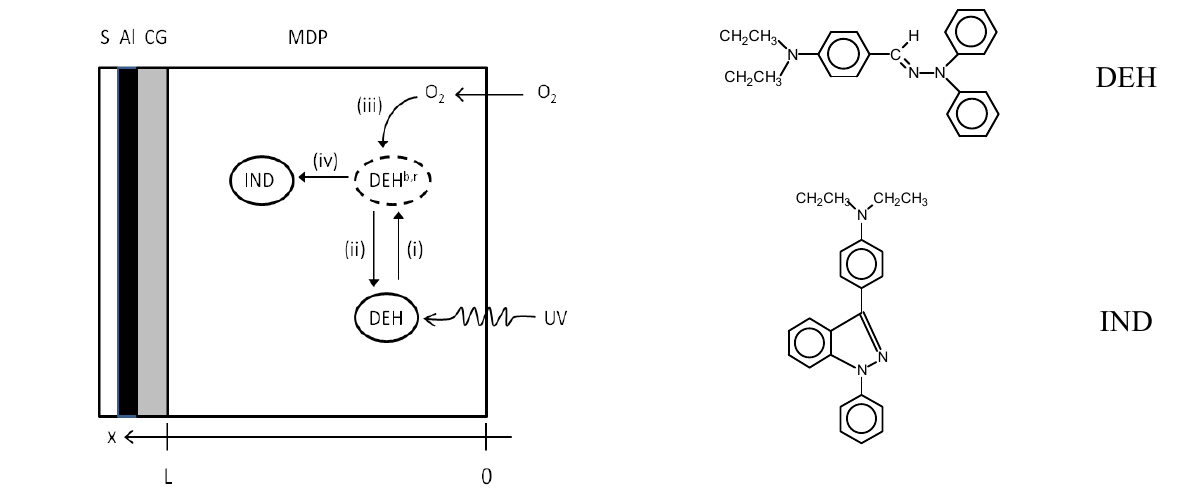
Figure 3. Photo-cyclic oxidation model for DEH MDP film structures according to processes (i)–(iv) described in the text. The chemical structures of the DEH and IND molecules are indicated. S =